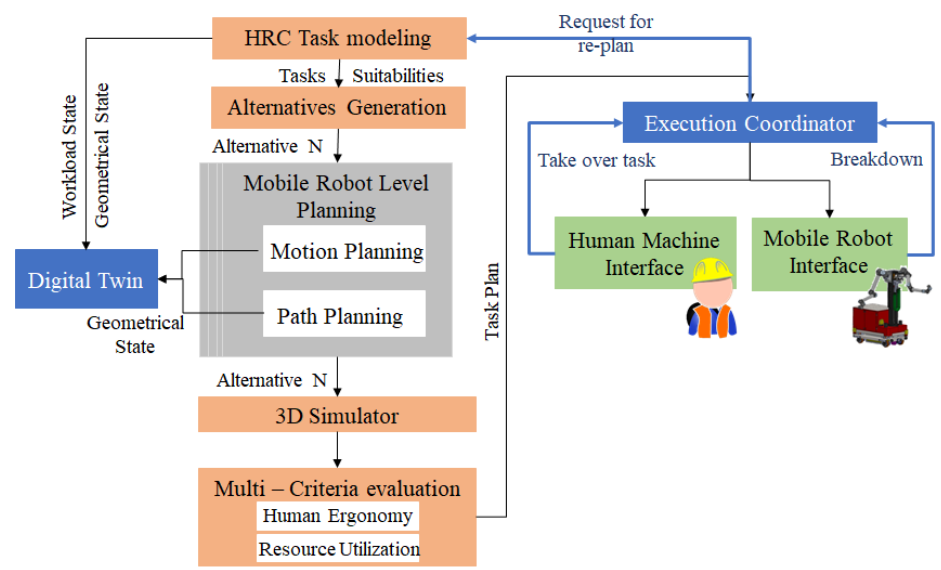
Figure 1. Proposed DT-based reconfiguration concept.